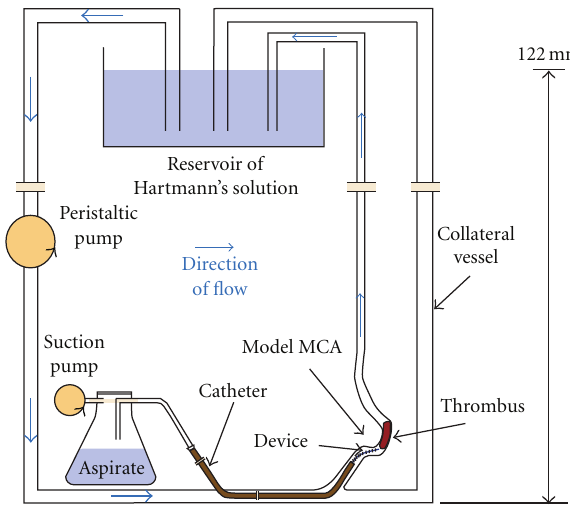
Figure 1: Diagram of the pulsatile flow system. Blue arrows indicate direction of perfusate flow.